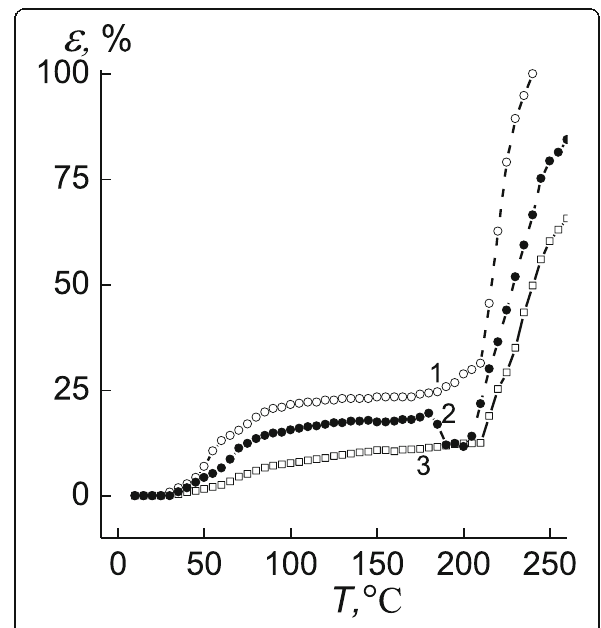
Fig. 4 Thermomechanical curves of 1 pectin, and 2 P4VP. ε is relative value of penetration